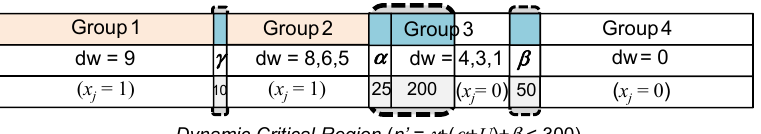
Figure 12. Four groups of object classification and efficient filtering for remaining n (cid:48) < 300. 3 GH + solutions and dw (dynamic weight) for filtering X